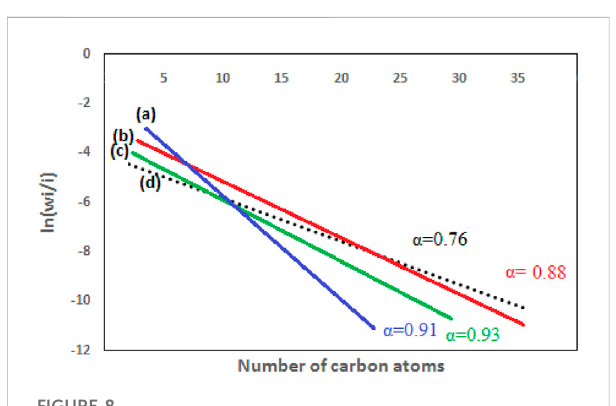
FIGURE 8 Product composition: (A) P. MOF.S (B) MOF. N (C) P. MOF.N and (D)